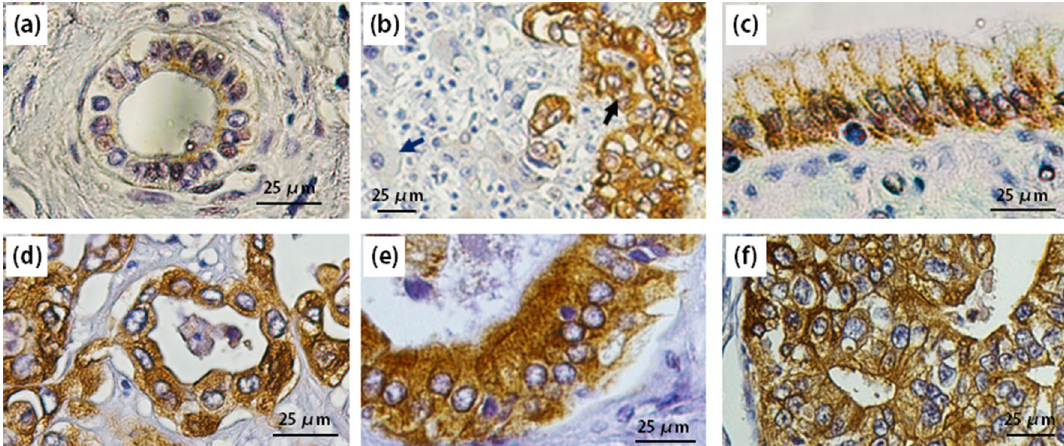
Figure 1. Expression of MUC1 protein in cholangiocarcinoma tissue samples. MUC1 protein in CCA was detected by immunohistochemistry (IHC). ( a ) Normal bile duct tissue. ( b ) The adjacent area of normal (liver) and cancerous (CCA) tissues (indicated by blue and black arrow, respectively). ( c – f ) Four tissue samples from four individual patients with CCA. In the positive areas, MUC1 were stained in both cytoplasm and on cell